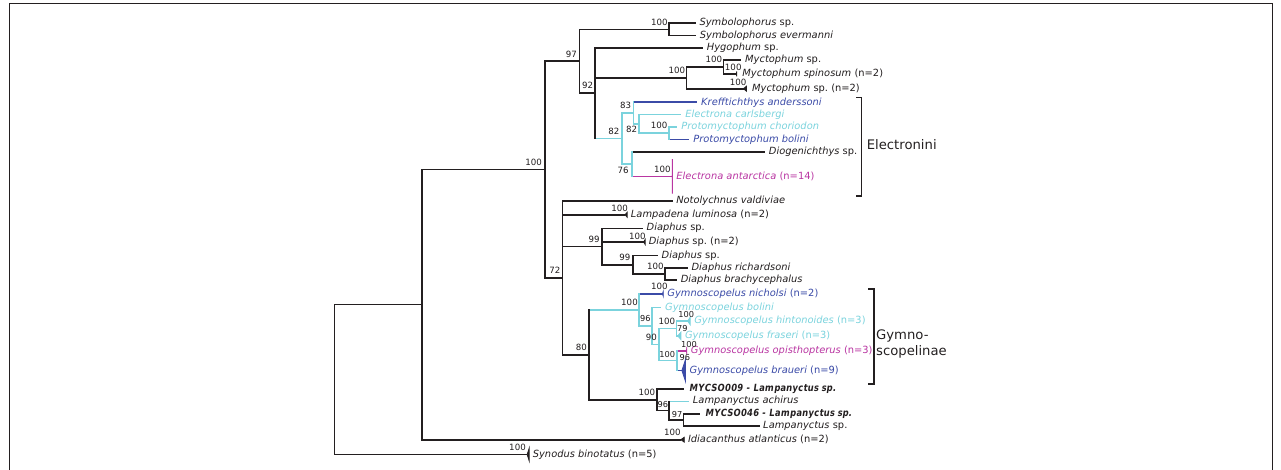
FIGURE 4 | Phylogenetic consensus tree of myctophid fishes based on cytochrome c oxidase I ( COI ) and rhodopsin ( rh1 ) gene variation using a maximum likelihood analysis with 10,000 bootstrap permutations. Bootstrap support > 70 is shown above the branches; branches with lower support are collapsed to polytomies; species with Antarctic, broadly Antarctic, and sub-Antarctic distribution pattern following Duhamel et al. (2014) are depicted in purple, dark blue, and light blue, respectively (color figure available online). Number of collapsed samples noted in brackets.